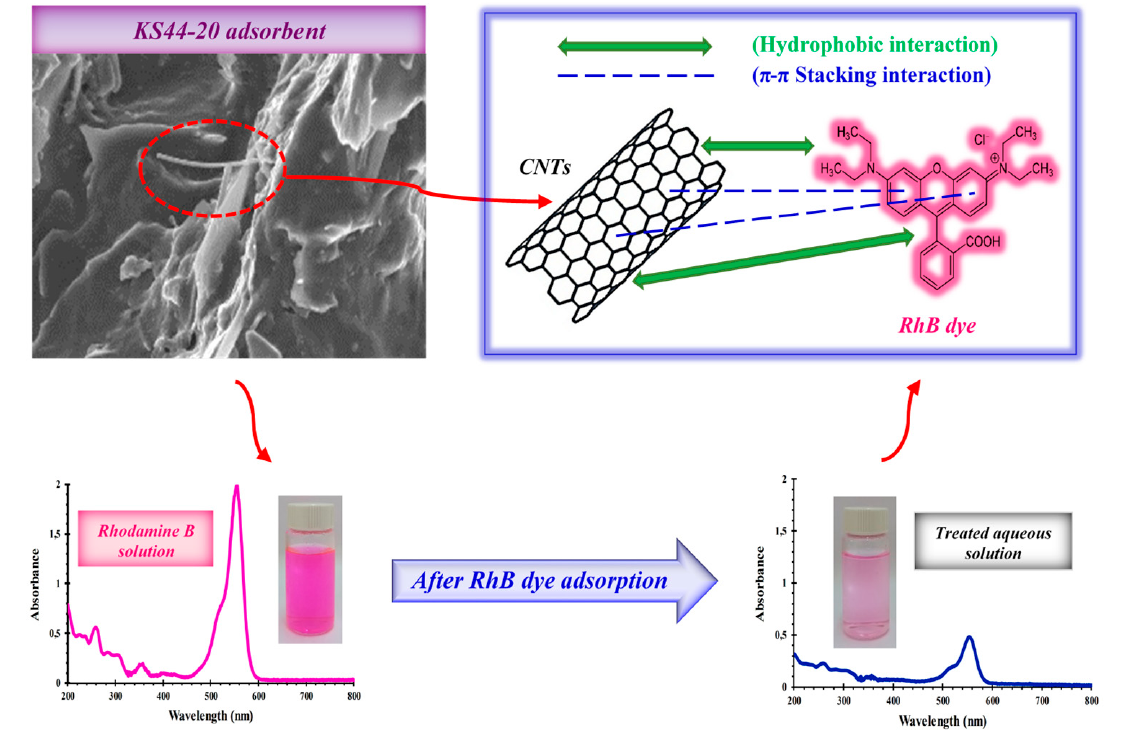
Figure 11. Mechanism of adsorption for the removal of RhB dye onto carbon composites ((RhB) = 10 mg.L − 1 , T = 20 °C, pH = 3 and time = 3 h.